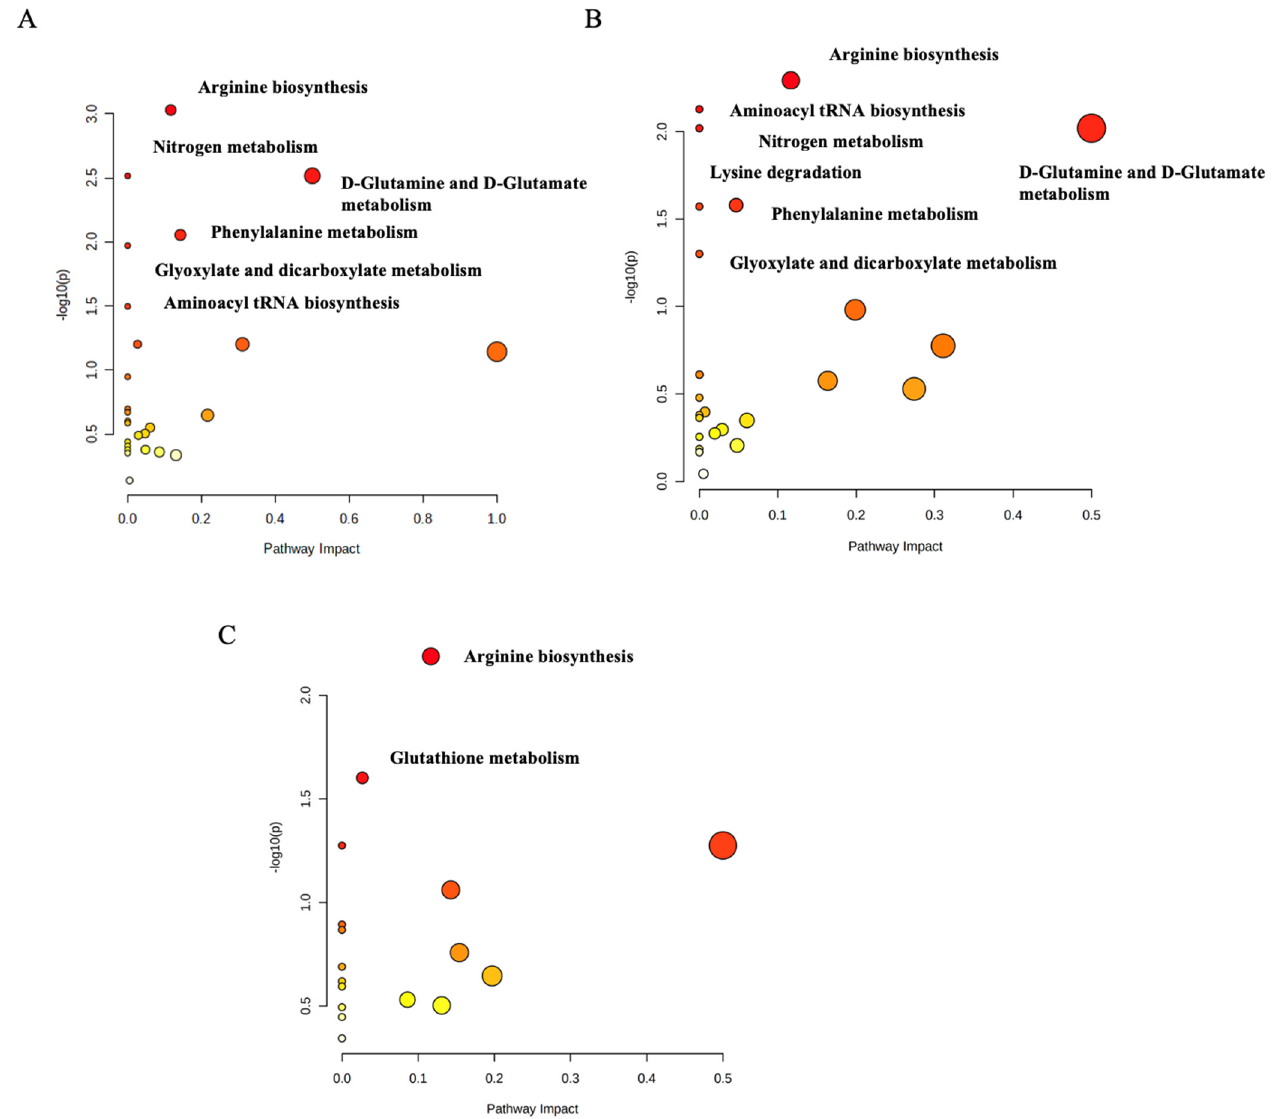
Figure 5. Pathway analysis of ( A ) the normoglycemic MetS group and the control group; ( B ) the controls and the prediabetic MetS group; ( C ) the normoglycemic MetS and the prediabetic MetS groups .